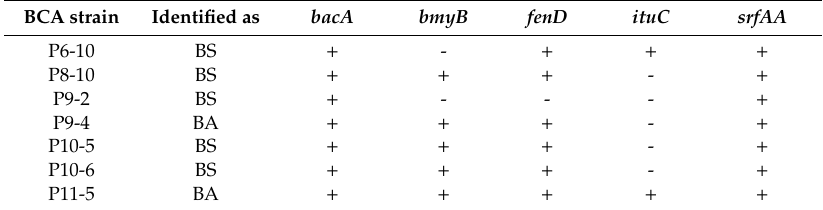
Table 6. Presence ( + ) / absence (-) of the biosynthetic genes bacA , bmyB , fend , ituC and srfAA in the selected biological control agent (BCA).